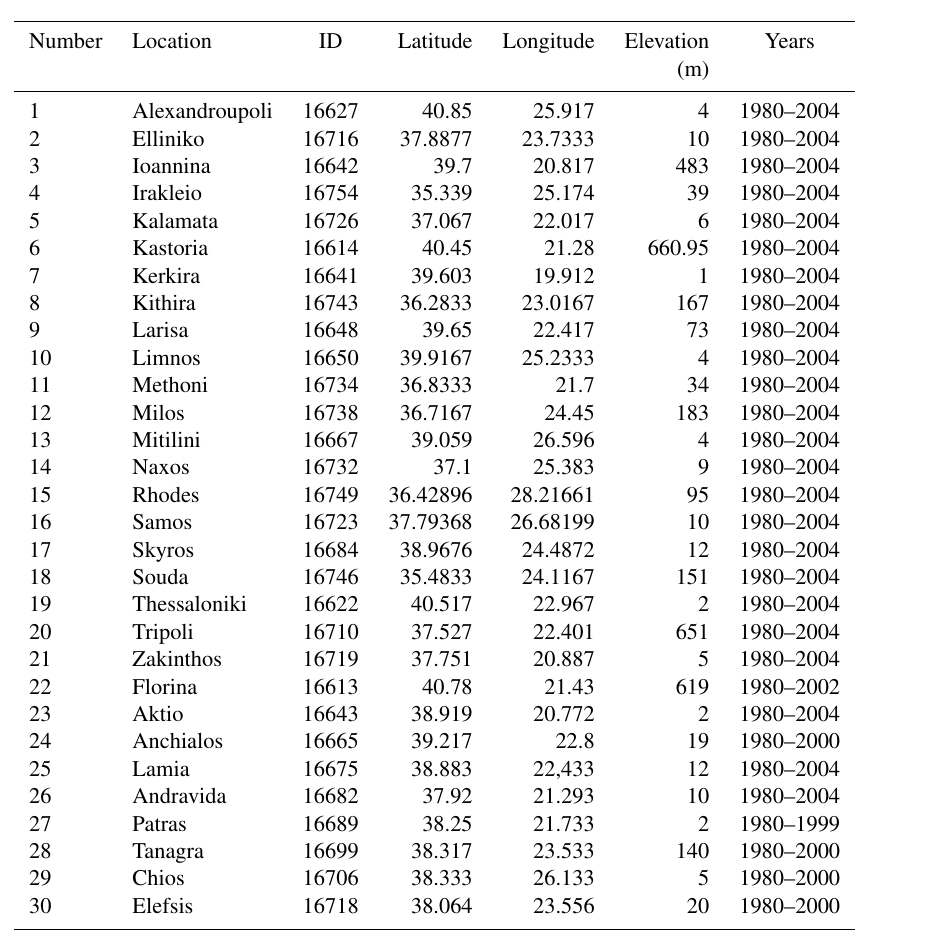
Table A1. HNMS stations